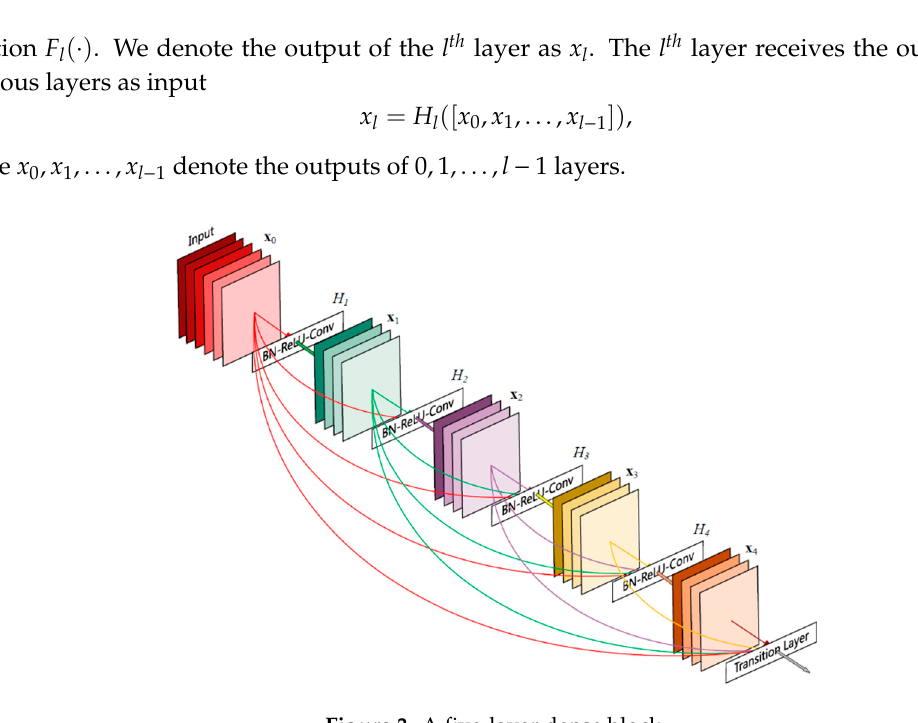
Figure 3 . A five-layer dense block. Figure 3. A five-layer dense block.